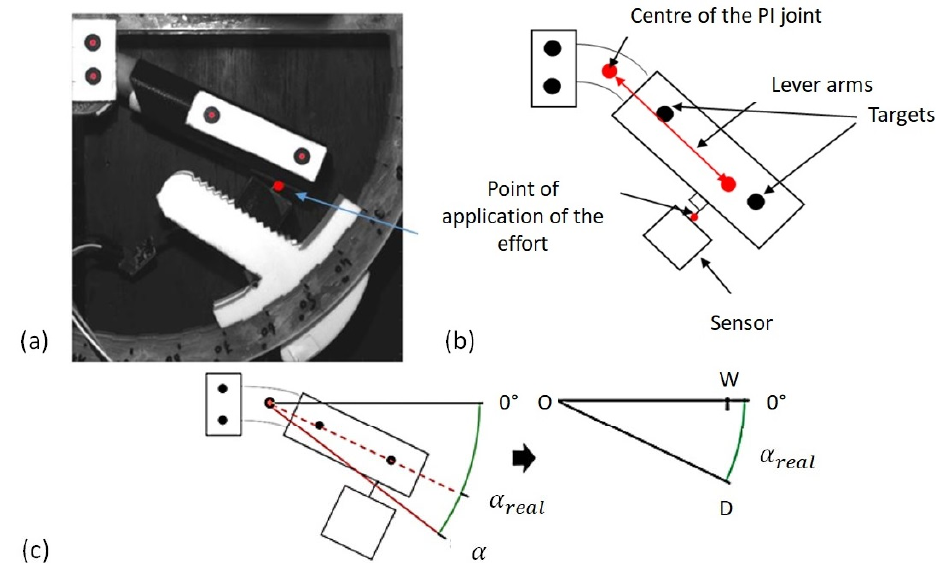
Figure 5. Setting up of the system and means of measurement. ( a ) Positioning of the targets and the point of application of the force, ( b ) determination of the lever arm between the centre of rotation and the point of application of the force, ( c ) evaluation of the real angle during the